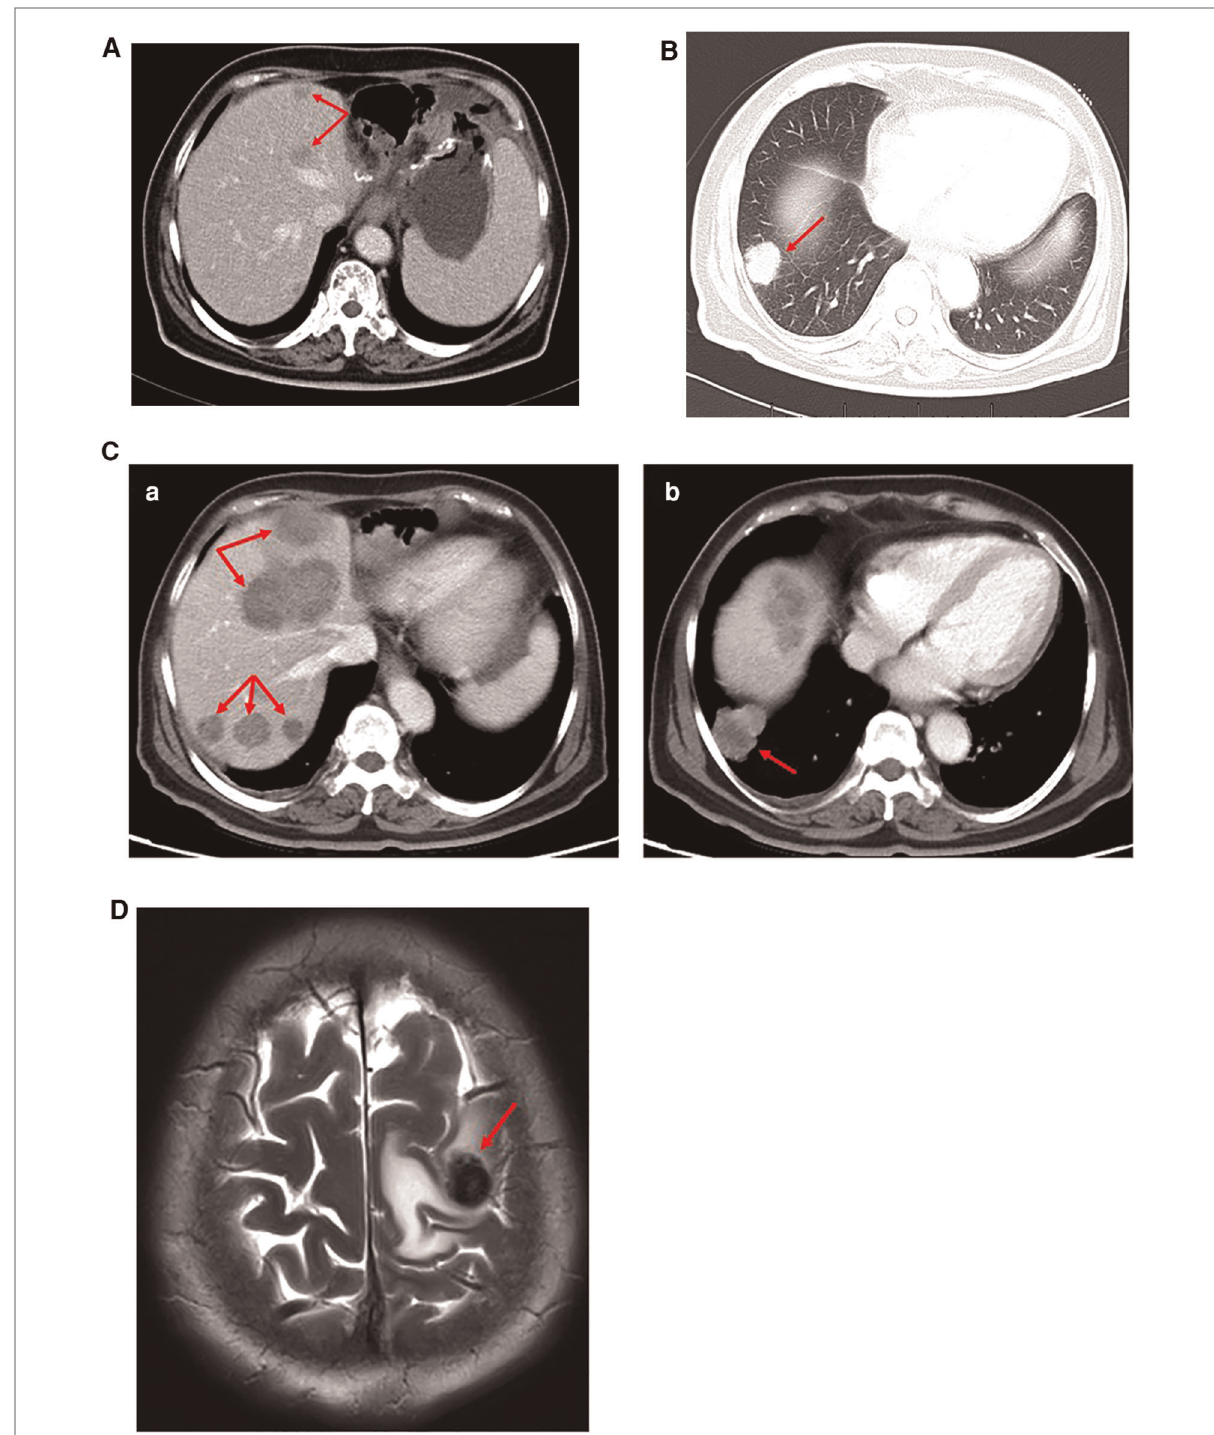
FIGURE 4 ( A ) CT examination (July 28, 2020): many slightly low-density lesions in the liver, considering metastasis. ( B ) CT examination (September 14, 2020): Right pulmonary nodule, considering metastasis. ( C ) CT examination (November 19, 2020): (a) Multiple low-density liver metastases (more and larger than before). (b) The metastatic nodules in the lower lobe of the right lung were larger than before. ( D ) MR examination (March 18, 2021): Brain